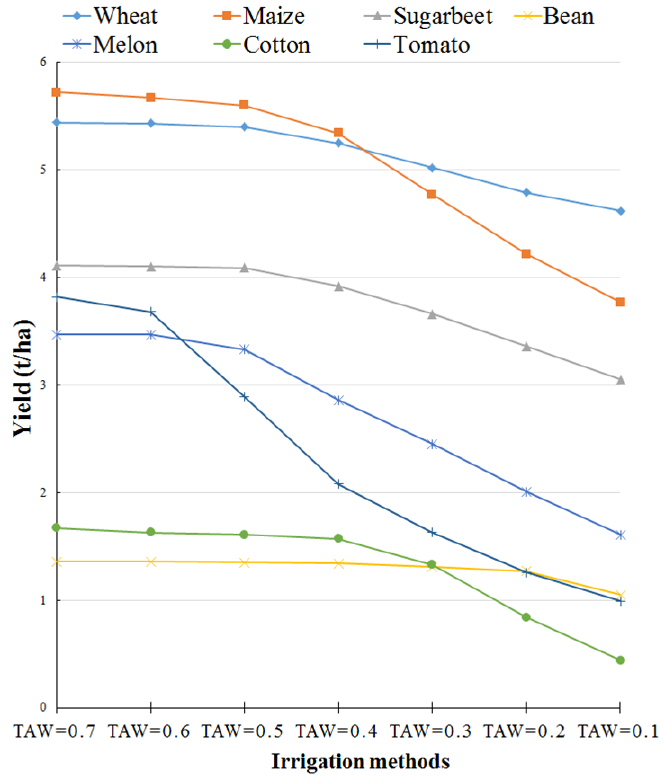
Figure 6. Irrigation scenarios based on fraction of total available water (TAW). Average yield performance of crops showing in the whole irrigation field within three-year simulation